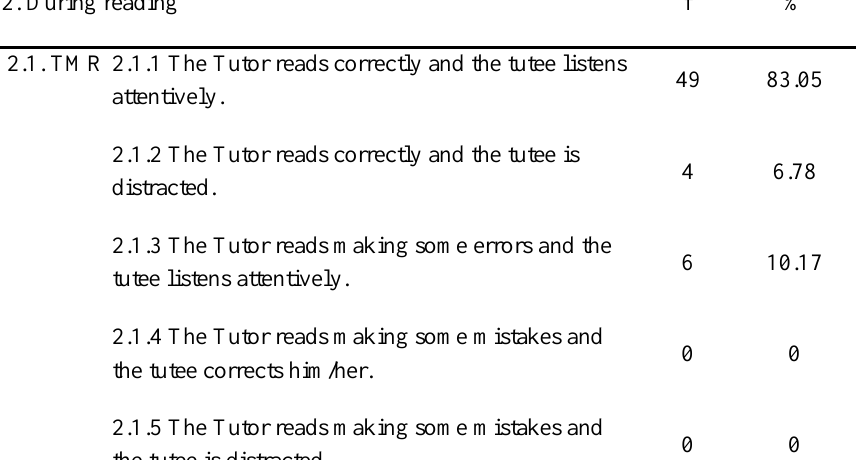
Distribution of frequencies according to dimensions and categories segment 2. During reading 2. During